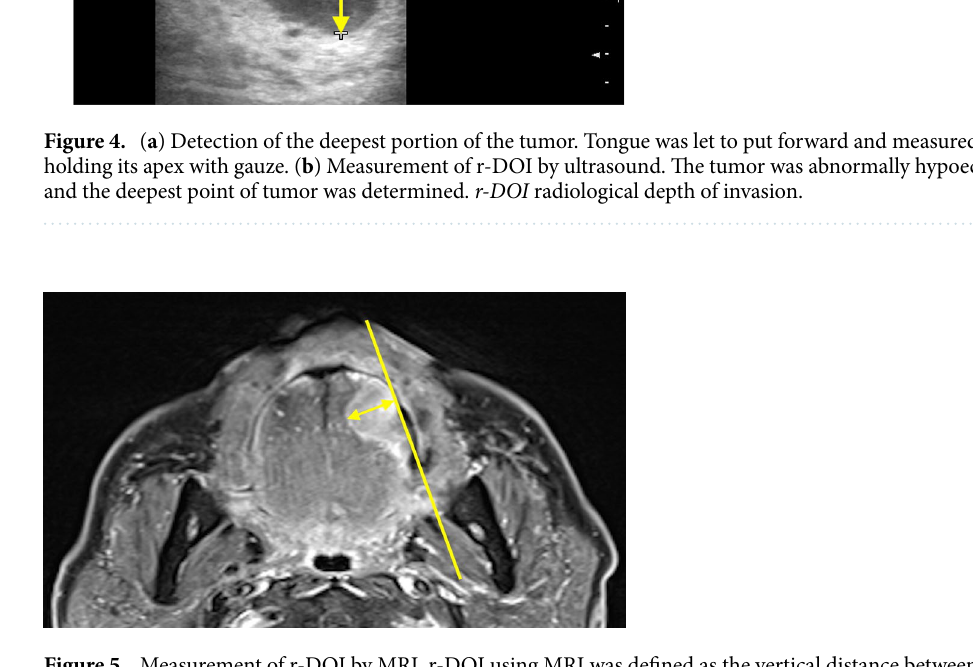
Figure 5. Measurement of r-DOI by MRI. r-DOI using MRI was defined as the vertical distance between the deepest point of the tumor infiltration and the simulated normal mucosal junction. r-DOI radiological depth of